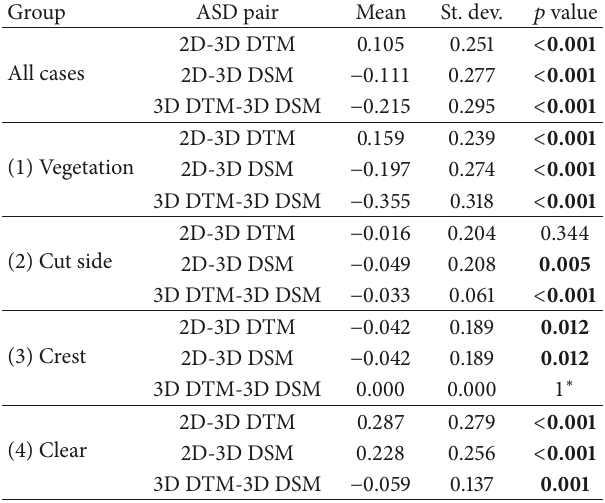
values among the three models. nc